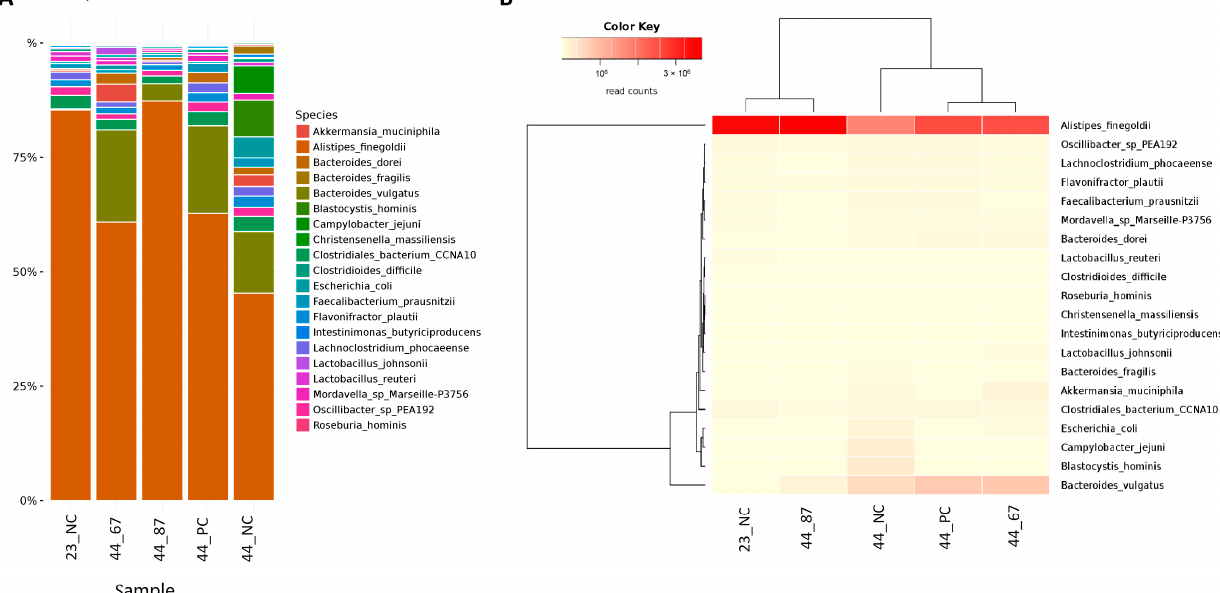
Figure 3. ( A ) Species abundance and their relationships across samples. ( B ) Dendrograms determined by computing hierarchical clustering from the abundance levels, showing the relationship between the species (left) and the samples (top). The abundance levels (number of reads associated with each taxa) were logarithmically transformed to base 2 for